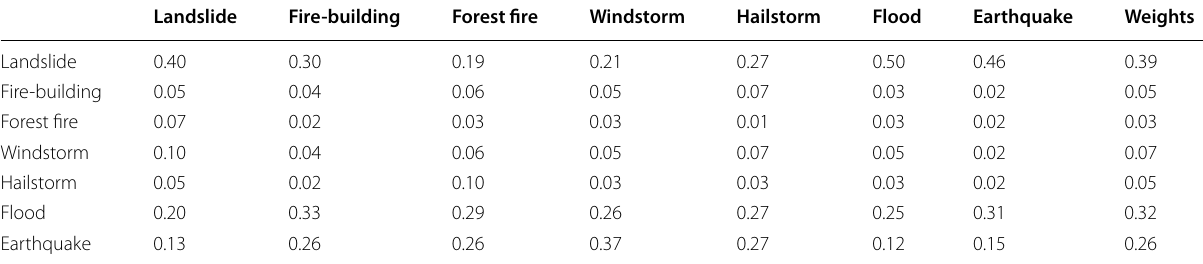
Table 7 Normalized priority ranking and corresponding weights Landslide Fire-building Forest fire Windstorm Hailstorm Flood Earthquake Weights